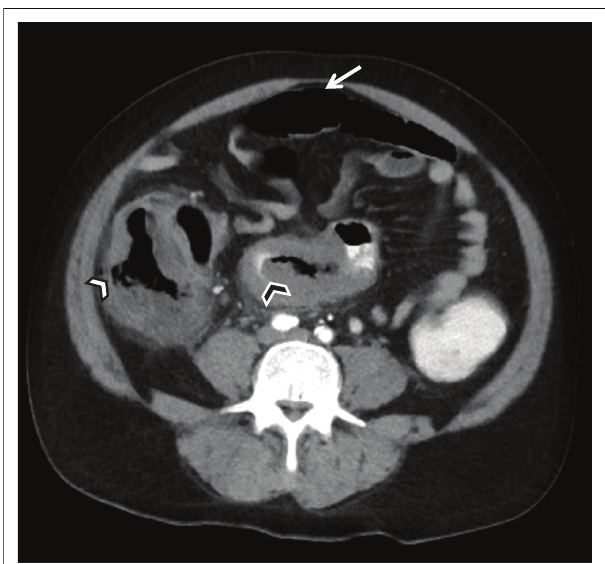
Note: The white arrow head shows the deep ulceration in the ascending colon; the white arrow points to the normal calibre (spared) colon wall and the black arrow head shows the thickened loops of sigmoid colon with intramural tracking of contrast. Source : CT image of actual patient captured by S. Mewa Kinoo FIGURE 1: Computed tomography scan with triple